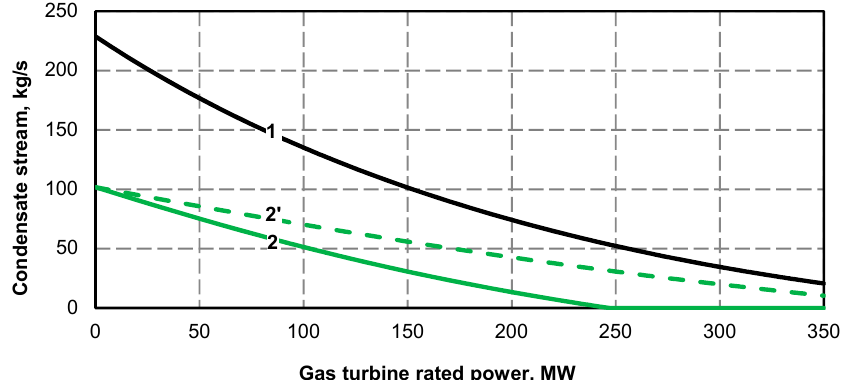
Figure 17. The stream of condensate fed from the KQ1 condenser to the XN1–XN4 low-pressure heat recovery exchangers as a function of gas turbine power: 1 – maximum fixed stream of 319.4 kg/s fresh steam fed to steam turbine; 2 – minimum steam boiler output of 133.3 kg/s and gas turbine operating with rated power, 2’– minimum steam boiler output of 133.3 kg/s and gas turbine operating with 60% of its rated power.